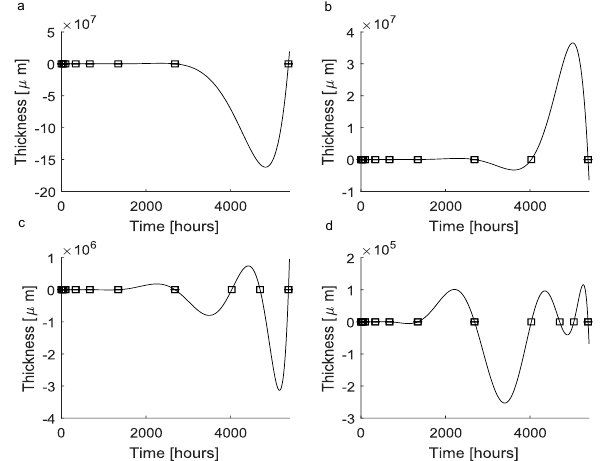
Figure 2. Interpolation through standard Lagrange polynomials: ( a ) Standard Lagrange polynomials (solid lines) were able to fit all the experimental data points (black squares). In this case, the function was the same as the function in Figure 1a, which was obtained through the Vandermonde-based interpolation. As a consequence, the numerical problems affecting the prediction of the thickness over time were the same. ( b ) Lagrange polynomials fitting all experimental points together with an extrapolated supplementary point. This function was still affected by the Runge phenomenon, but the magnitude of differences between predictions and experimental values was lower (i.e., about 1 × 10 7 ). ( c ) Lagrange polynomials fitting all experimental points together with two extrapolated supplementary points. Numerical errors still affected the interpolating function leading to non- physical predictions, even if the magnitude of errors was lowered to about 1 × 10 6 . ( d ) Lagrange polynomials fitting all experimental points together with three extrapolated supplementary points. The Runge phenomenon still affected the interpolating polynomial function, which again resulted in nonphysical predictions. The magnitude of errors was further lowered to about 1 × 10 5 .